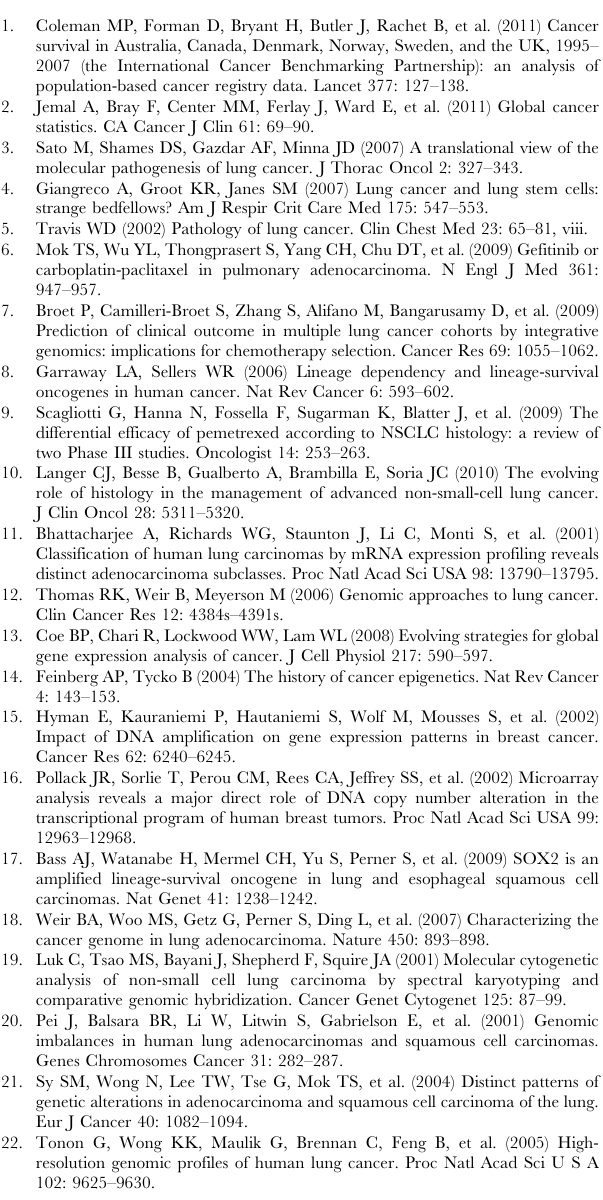
Table S5 IPA network analysis of subtype specific copy number alteration target genes. Table S6 Genes deregulated by DNA methylation in each subtype. Table S7 IPA network analysis of subtype specific methylation target genes. Table S8 Genes disrupted by gene-dosage in one subtype and DNA methylation in the other. Table S9 Genes demonstrating concerted genetic, epi- genetic and transcriptional disruption in SqCC.